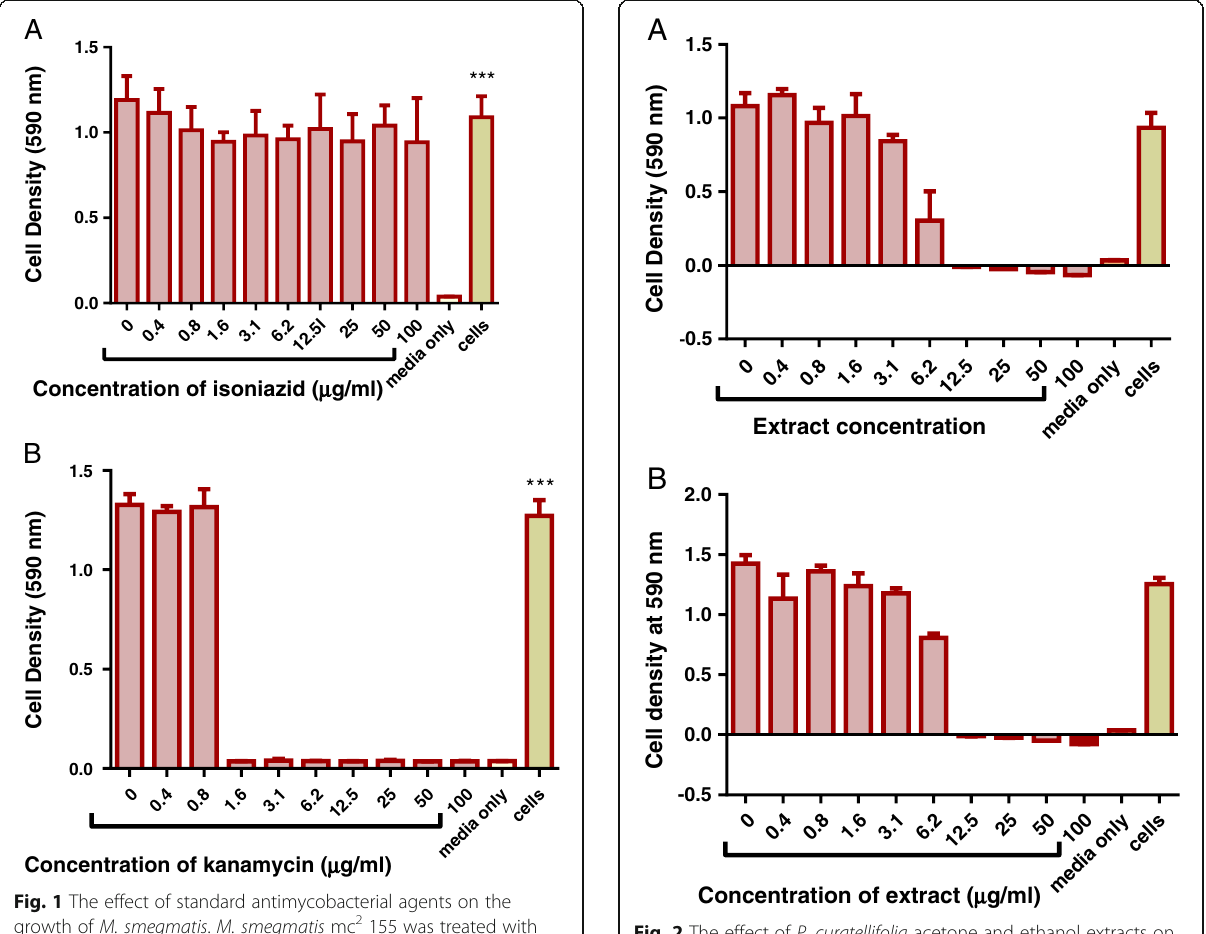
Fig. 2 The effect of P. curatellifolia acetone and ethanol extracts on the growth of M. smegmatis . M. smegmatis mc 2 155 laboratory strain at concentration of 2 × 10 6 cfu/mL was treated with different concentrations of the acetone ( a ) and ethanol extract ( b ) from 0 μ g/ml up to 100 μ g/ml. The bacteria were incubated with extracts at 37 ̊ C for 20 h and cell density was determined by measuring absorbance of reduced MTT at 590 nm. The error bars on the graphs indicate the standard deviation from mean ( n = 4). Dunnet ’ s multiple comparison test was used to compare columns using Graphpad prism 6 software. The asterisks (*) indicate statistical significant differences with the sterility control (media) * < 0.05 *** <